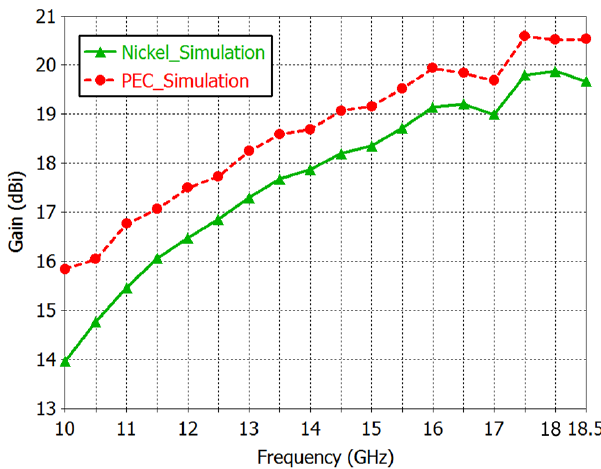
Figure 4: The simulation results for the gain of the proposed antennas with PLA/nickel materials and PEC material.